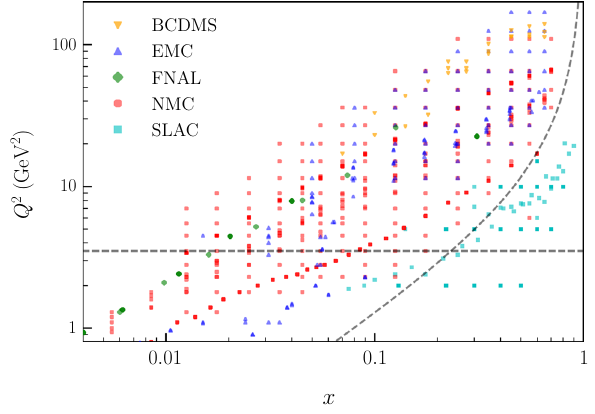
Fig. 1 Kinematical coverage in the ( x , Q 2 ) plane of the DIS neutral- currentnuclearstructurefunctiondataincludedinnNNPDF1.0,assum- marized in Table 1. The horizontal dashed and curved dashed lines cor- respond to Q 2 = 3 . 5 GeV 2 and W 2 = 12 . 5 GeV 2 , respectively,